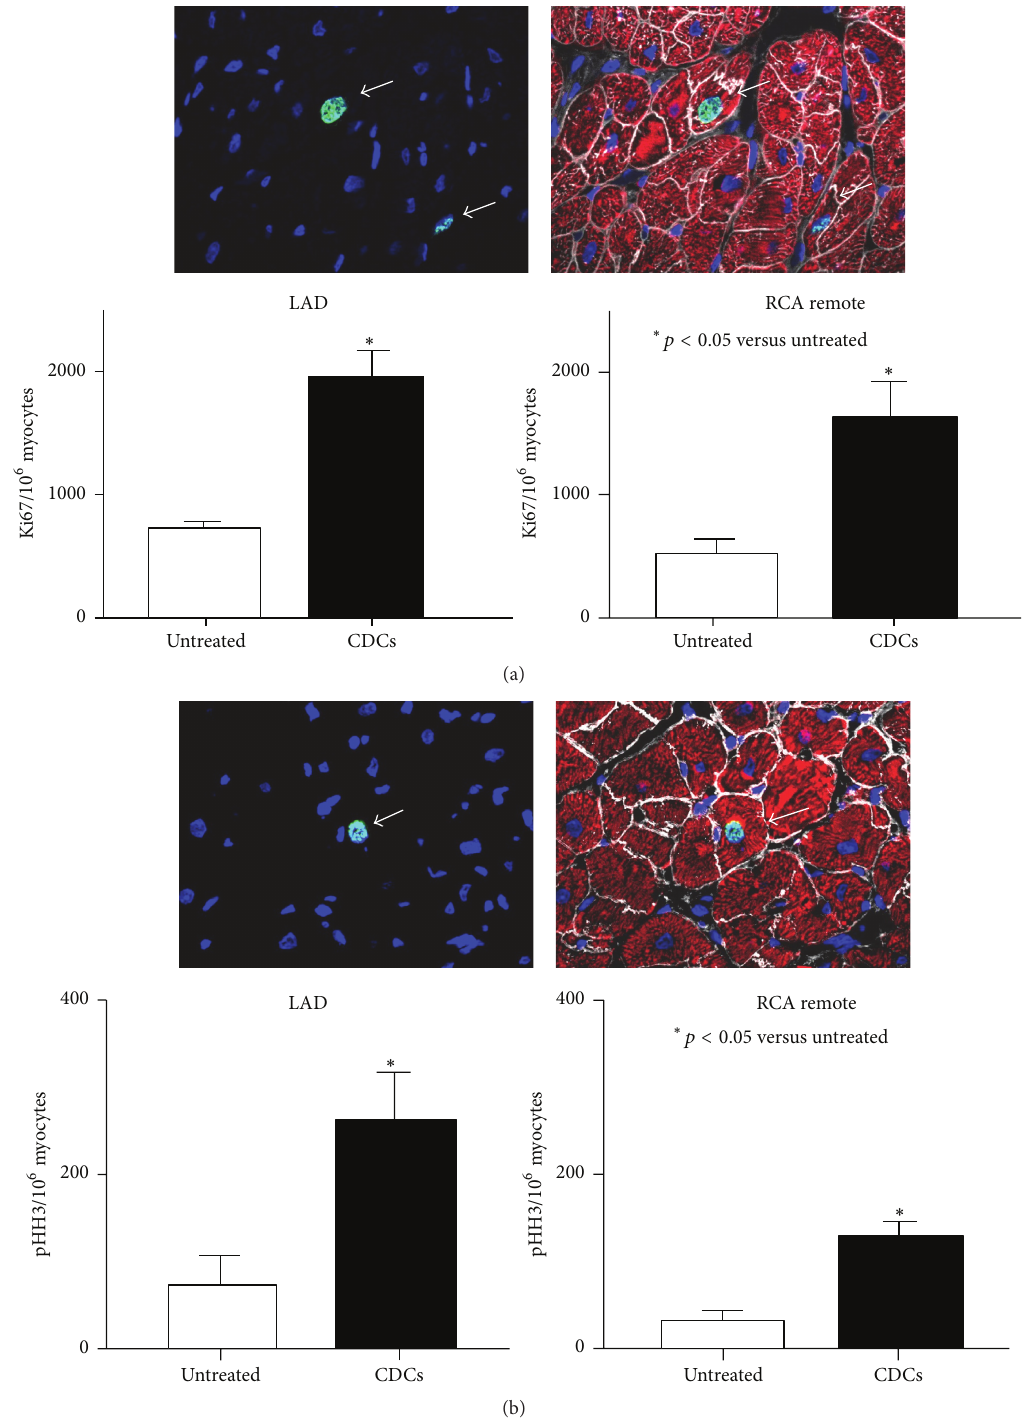
Figure 5: The effect of CDCs on proliferating myocytes. (a) The upper panel shows a Ki67 positive nucleus localized in a cardiac myocyte. Two Ki67 positive nuclei (green, arrows) colocalized with myocytes stained with Troponin I (red). The number of cardiac myocytes in the growth phase of the cell cycle was evaluated with Ki67. Four weeks after CDCs, Ki67 positive myocytes were significantly increased in both LAD and RCA remote regions versus untreated controls. (b) pHH3 positive nuclei (green, arrow) colocalized with myocytes (red). Cardiac myocytes in the mitotic phase were evaluated with phospho-Histone H3 (pHH3). Four weeks after CDCs, myocyte nuclei in the mitotic phase significantly increased in both LAD and RCA remote regions versus untreated